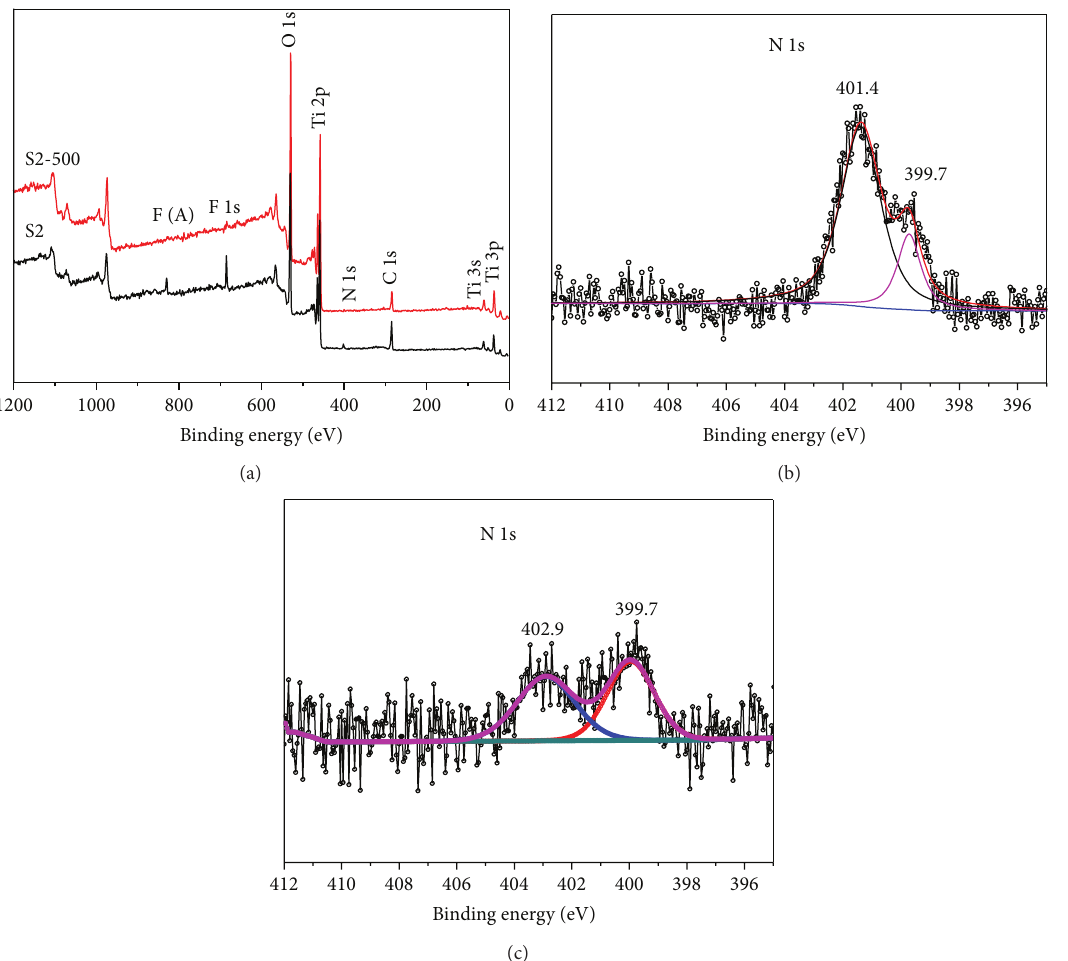
Figure 3: The XPS survey scan patterns of samples ((a) S2 and S2-500; (b) N 1s of S2; (c) N 1s of S2-500).